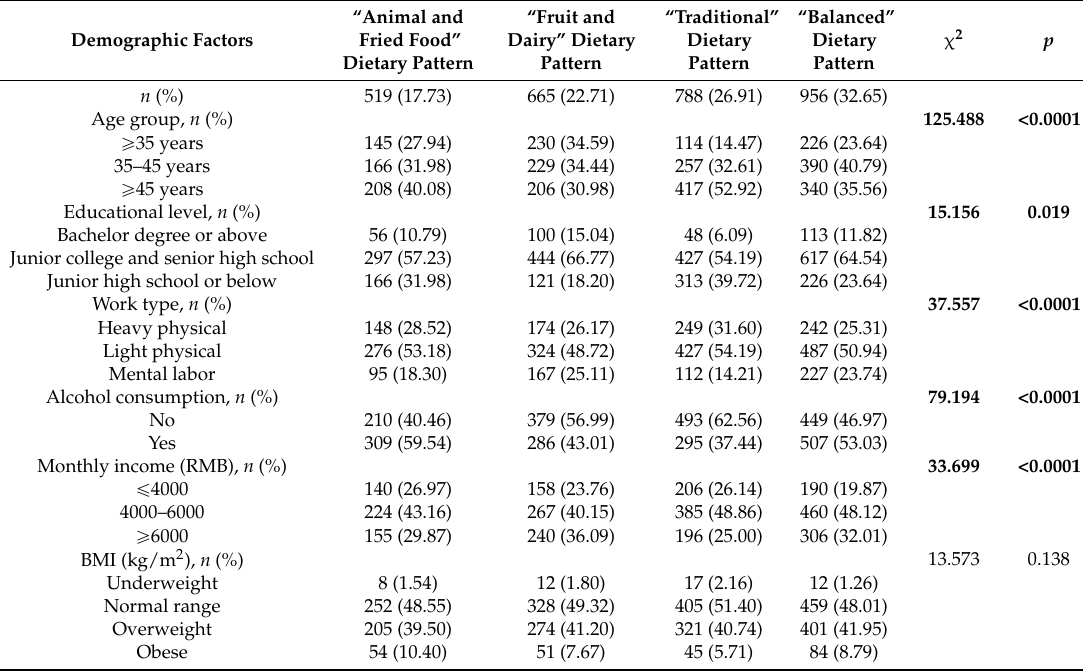
Table 6. Distributions of sample characteristics among men by four dietary patterns. “Animal and Demographic Factors Fried Food” Dietary Pattern